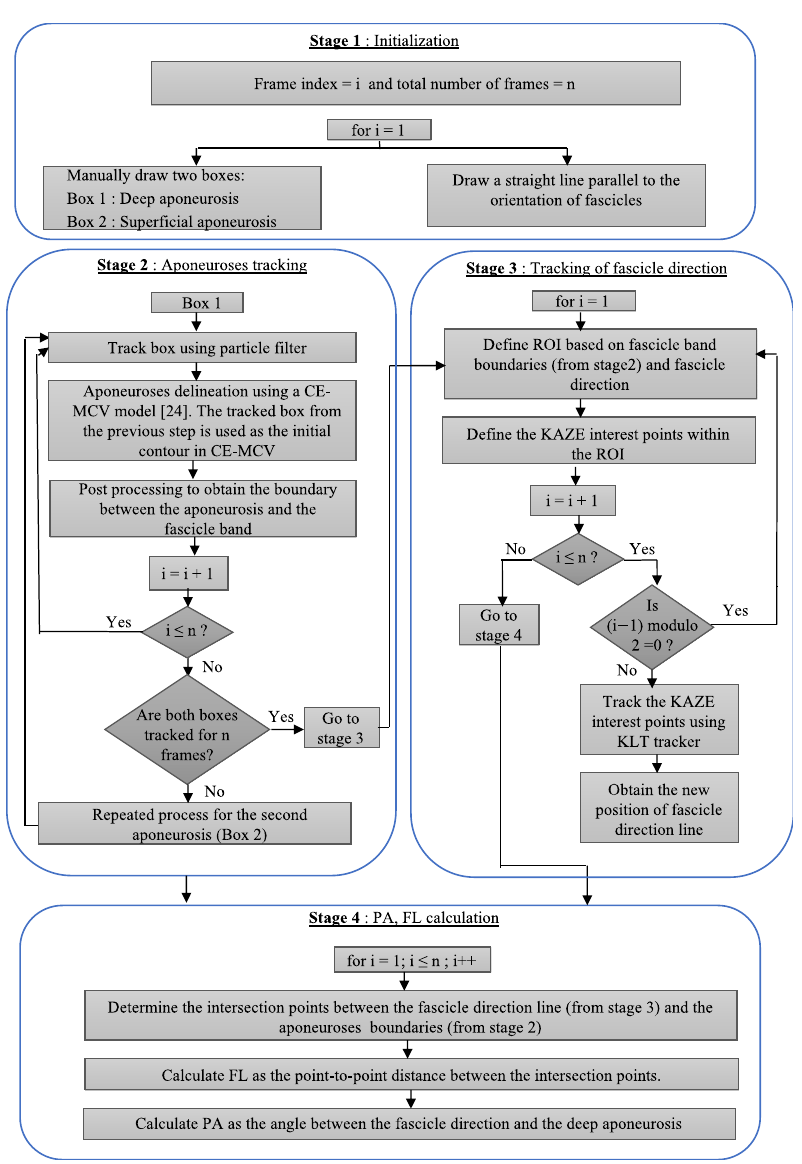
Figure 2. Flow diagram of the proposed approach for estimation of PA and FL. The proposed distortion pattern-based image-processing algorithm for the quantifica- tion of FL and PA consists of four